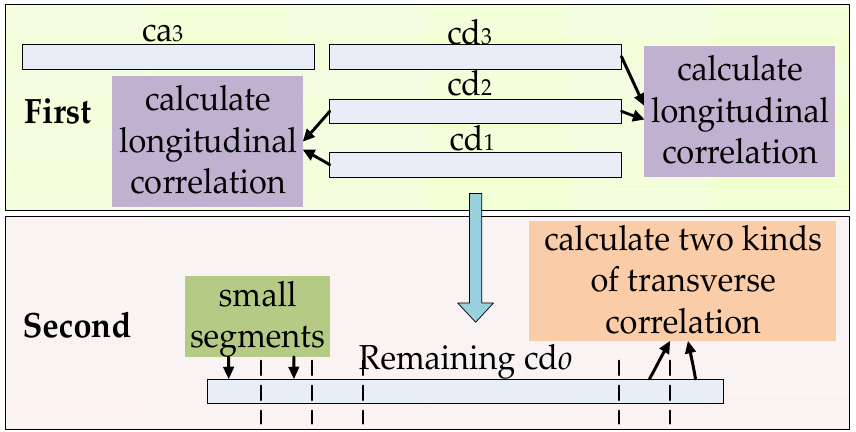
Figure 3. The two key steps of the TDDC wavelet filtering.